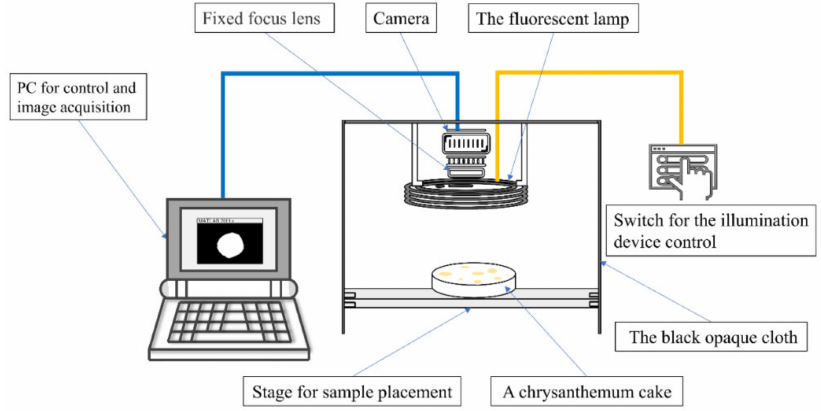
Figure 2. The schematic of the custom-built computer vision